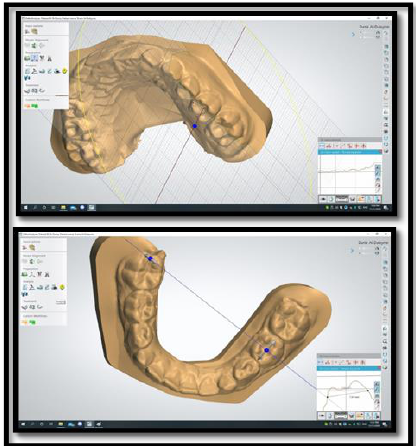
Figure 3: The maxillary and mandibular cast analyzing using 3 SHAPE ORTHOANALYZER